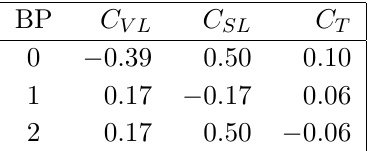
Table 2 . List of benchmark points for the distribution dBR( B ! D 0 (cid:3) (cid:28)(cid:23) ) = d(cos( (cid:18) V )) obtained from the clustering procedure given in terms of the left-handed vector, scalar and tensor Wilson coe(cid:14)cients C V L ; C SL and C T